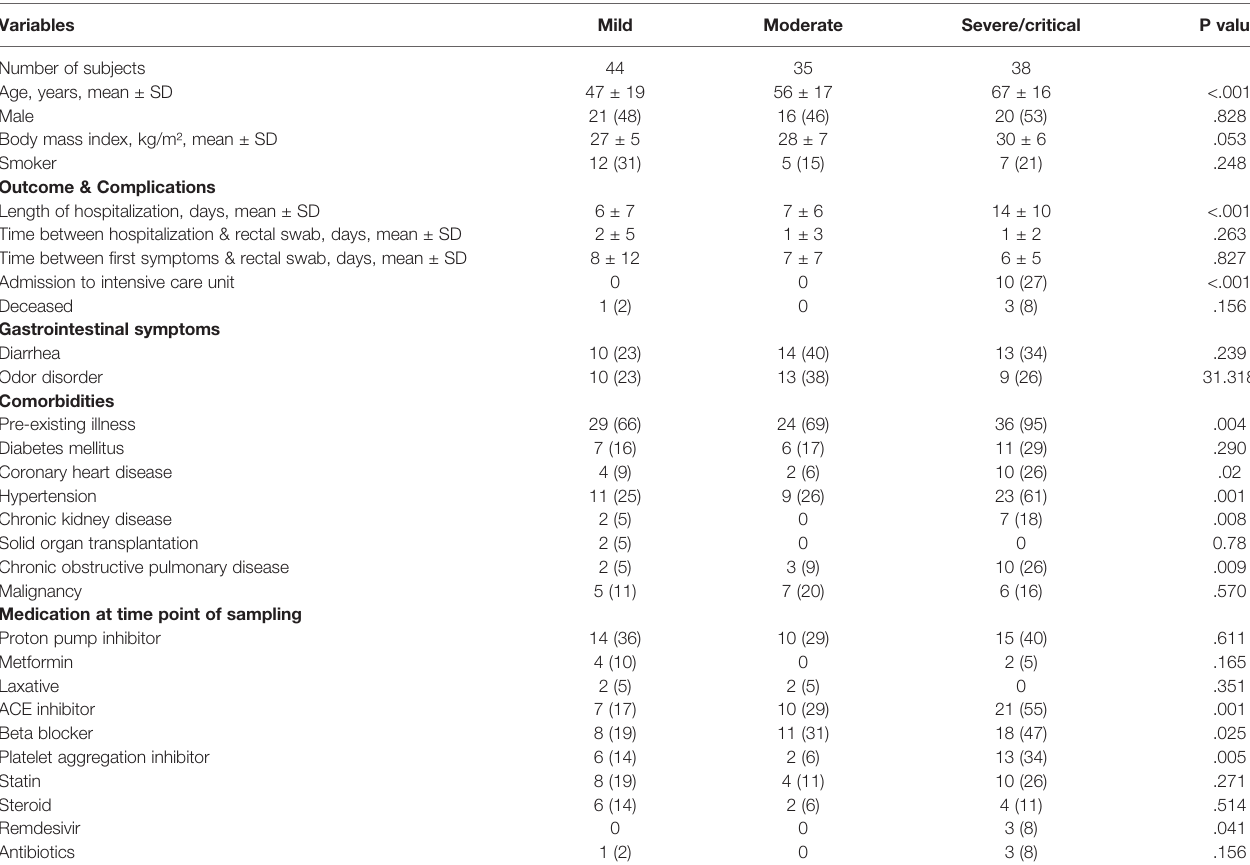
TABLE 2 | Patient characteristics of SARS-CoV-2 positive patients according to COVID-19 disease